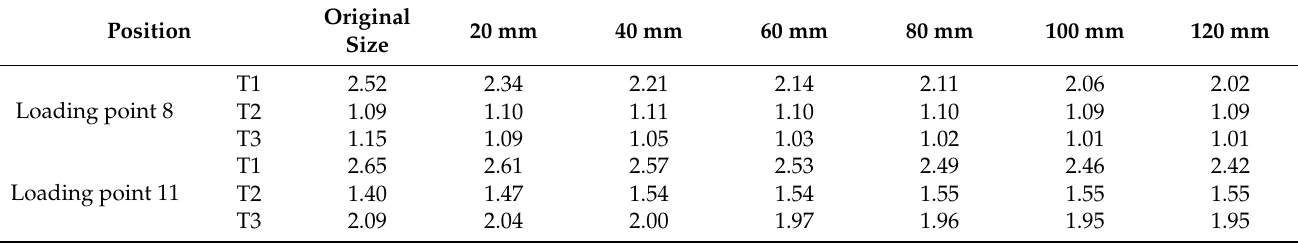
Table 14. Widen ILVT in the lateral direction